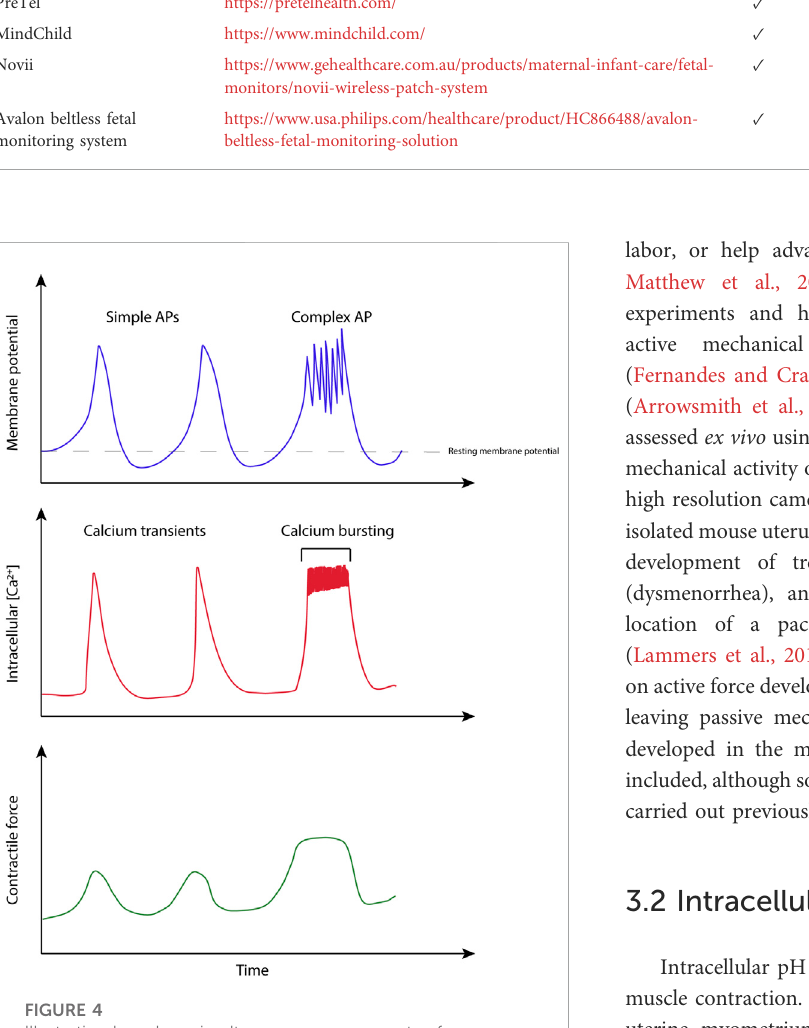
FIGURE 4 Illustration based on simultaneous measurements of electrical activity, calcium transients, and force in uterine smooth muscle. Adapted from experimental recordings from (Burdyga et al.,